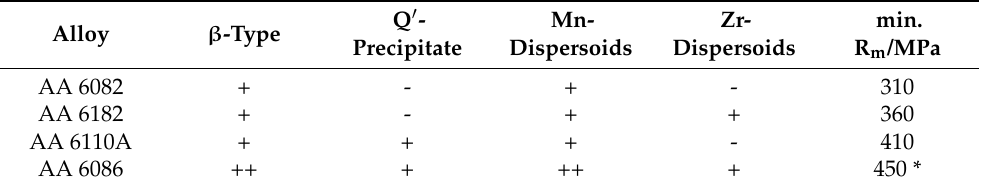
Table 4. The presence of precipitates and dispersoids in selected Al-alloys, and minimum tensile strengths R m in T6 temper according to EN 755-2:2016 (* possible minimum value for AA 6086, which is not yet included in EN 755-2:2016; -: not present, +: present, ++: present in a higher amount).